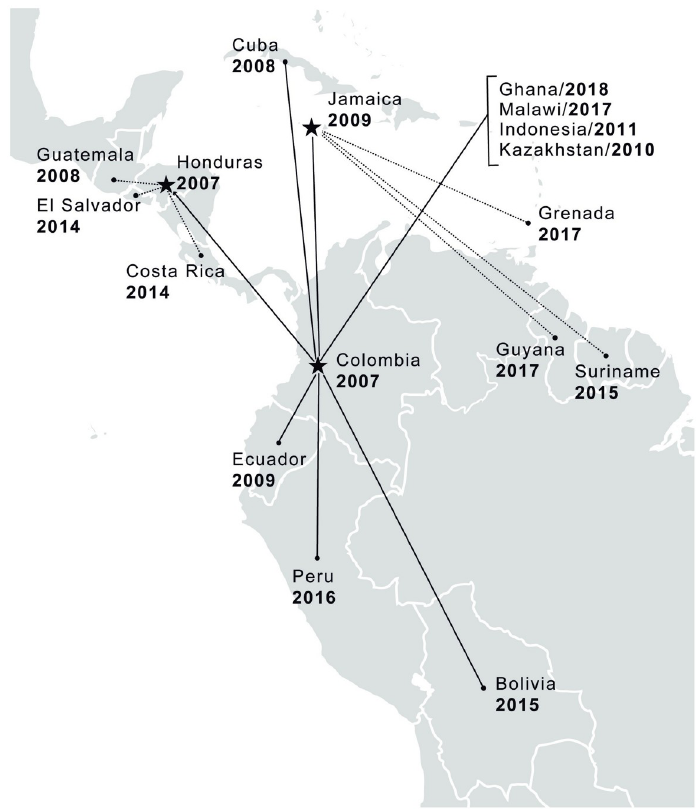
Fig 3. Geographic outreach of “Planning for Success” training: Countries and year of introduction of EPPE by the LAC-RTC and network institutions. Stars represent the RTC for the Americas (CIDEIM in Colombia) and network institutions that have become training hubs. Filled circles indicate countries where network institutions have replicated the EPPE course in their institution. Solid lines indicate the transfer of training directly imparted by CIDEIM. Dotted lines illustrate the secondary cascade of training by other network institutions with support and accompaniment by the RTC. (Illustration created from wikipedia/commons/0/03/BlankMap-World6.svg open-source map adapted using Adobe Illustrator from the CS bundle.) CIDEIM, Centro Internacional de Entrenamiento e Investigaciones Me´dicas; EPPE, Effective Project Planning and Evaluation; LAC, Latin American and Caribbean; RTC, Regional Training